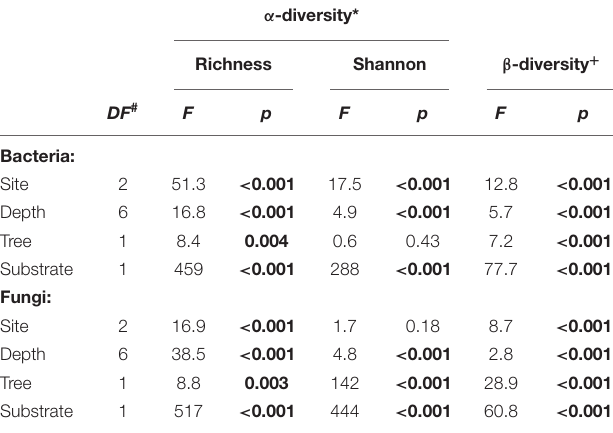
TABLE 5 | Main effects on bacterial and fungal α -diversity (Richness and Shannon index) and β -diversity (Bray–Curtis dissimilarities) of forest sites (Chamoson, Neunkirch, Saillon), soil depths (soil layers: L1: 0–10 cm, L2: 15–25 cm, L3: 45–55 cm, L4: 75–85 cm, L5: 110–125 cm, L6: 140–155 cm, L7: 180–200 cm), tree genera (beech, oaks), and substrates (bulk soil, fine roots). α -diversity*